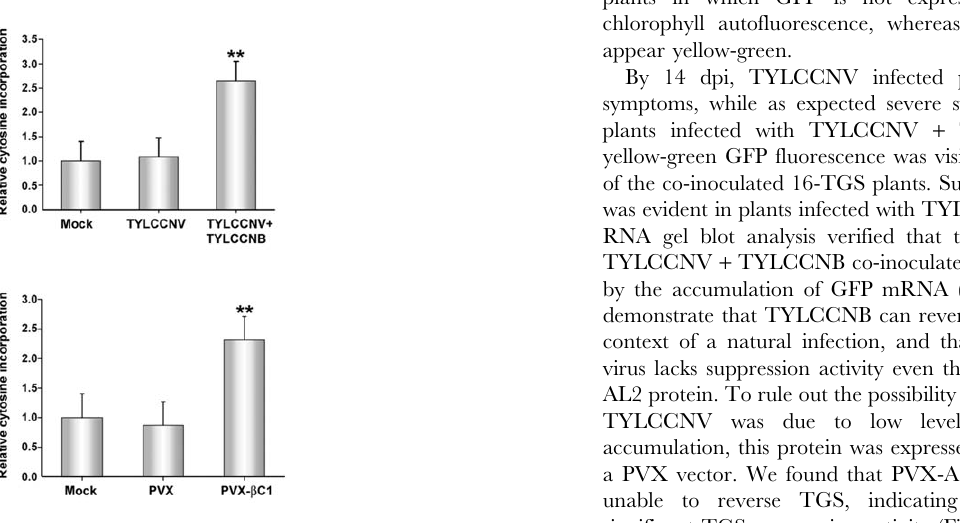
Figure 3. TYLCCNB, or b C1 expression, globally reduces cytosine methylation in the host genome. The histograms depict the relative 32 P-dCTP incorporation observed in methylation-sensitive extension assays. DNA was obtained from mock inoculated or infected plants, digested with MspI, and incubated with 32 P-dCTP and Taq polymerase to permit single-nucleotide extension. Increased incorpo- ration due to enhanced MspI cleavage indicates reduced methylation. (A) DNA was obtained from mock-inoculated plants, or plants inoculated with TYLCCNV or TYLCCNV + TYLCCNB. (B) DNA was obtained from mock-inoculated plants, or plants inoculated with PVX or PVX expressing b C1 protein (PVX- b C1). Both (A) and (B) represent data from two independent experiments. In each experiment, assays were performed in duplicate with DNA from three individual plants per treatment. Values represent means + /- SE. Double asterisks indicate significant differences between samples with and without TYLCCNB at the 99% confidence interval, as determined by Student’s t test.